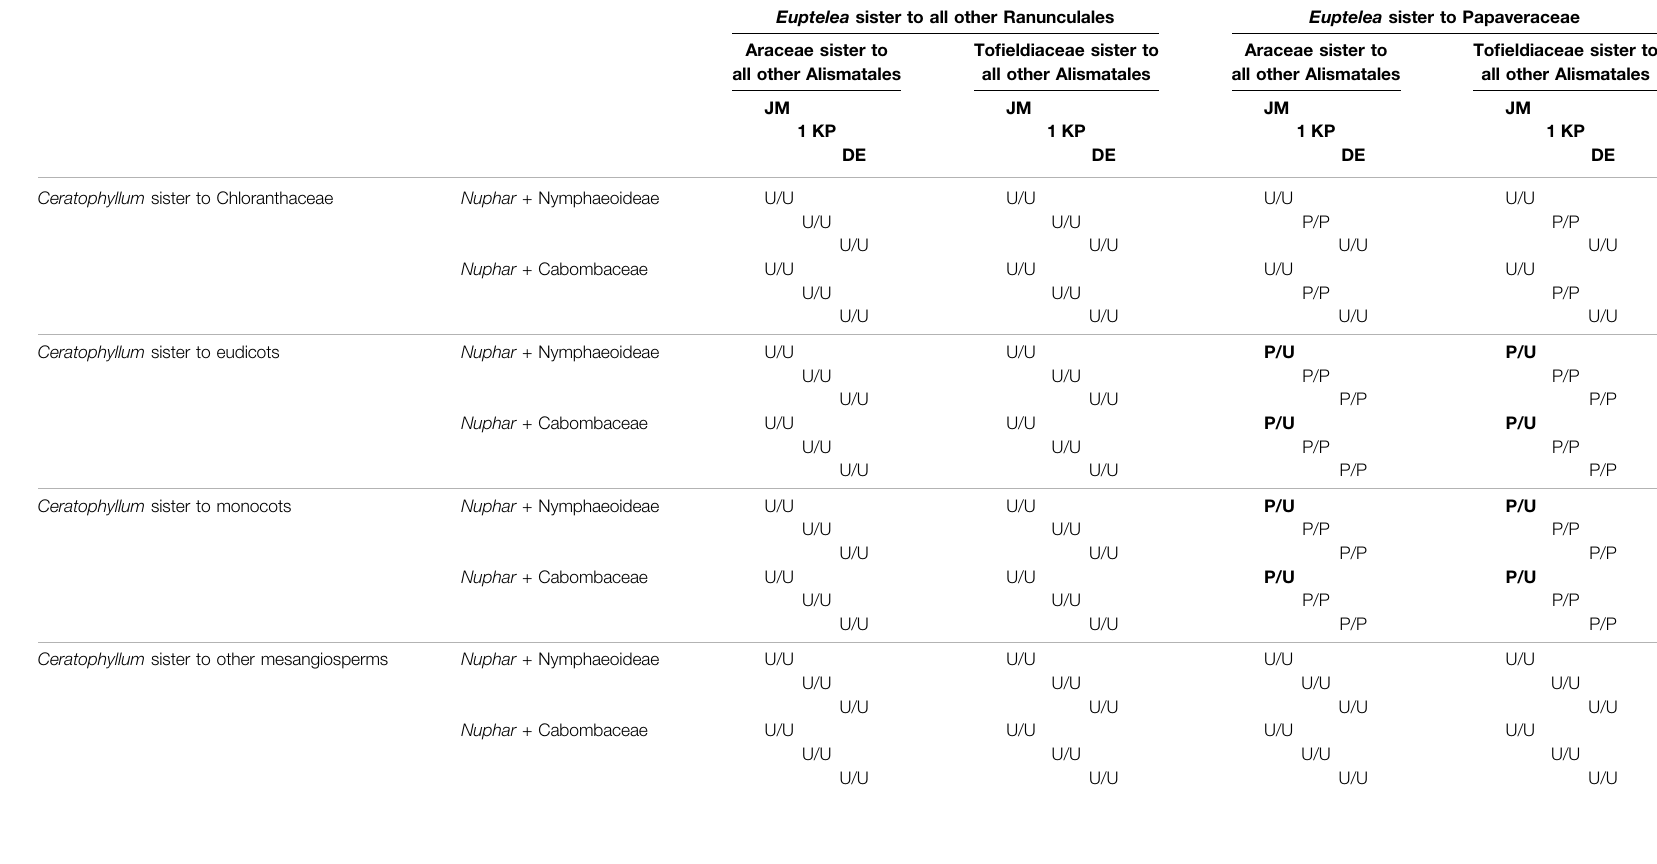
TABLE 1| Ancestral state reconstructions with parsimony forcarpelfusion inastem-group lineage of Ceratophyllum onthree differentmajor phylogenetic topologies (JM, 1 KP orDE) combined with allpossible positionsof Ceratophyllum , Nuphar , Euptelea andTo fi eldiaceae( Figure2 ),showingtowhatextentphylogeneticplacementaidshomologyreconstruction.Eachcellshowsreconstructedconditionsfor Ceratophyllum (towhichnoa priori state was assigned) in three contrasting topologies using the original (any fusion)/edited (congenital fusion) data from Sauquet et al. (2017). P = fusion between carpels present; U = presence or absence of fusion uncertain. Boldface indicates the conditions found in the eight topologies that are sensitive to the coding of